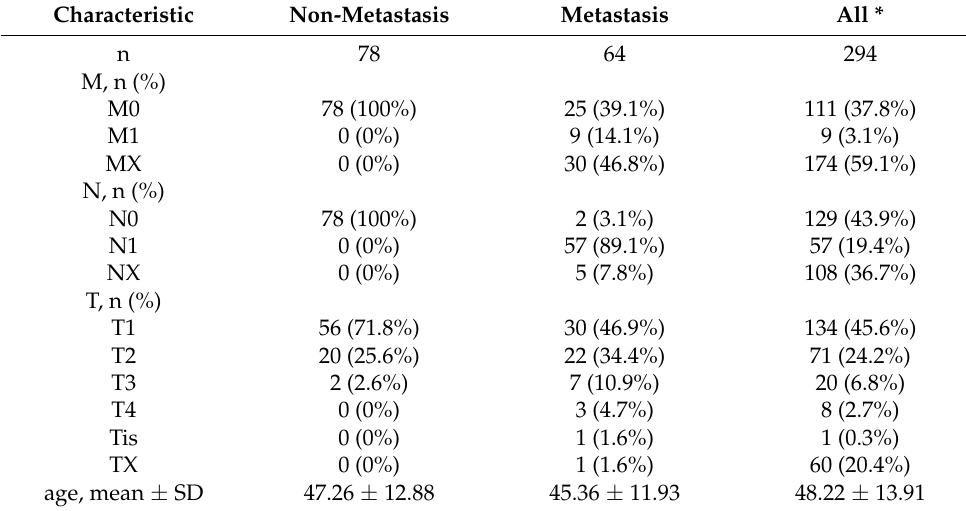
Figure 1. Flow chart illustrating the analysis of tumor metastasis-associated microbiomes in the TCGA–CESC. Table 1. Comparison of clinical baselines for different metastasis status subgroups.